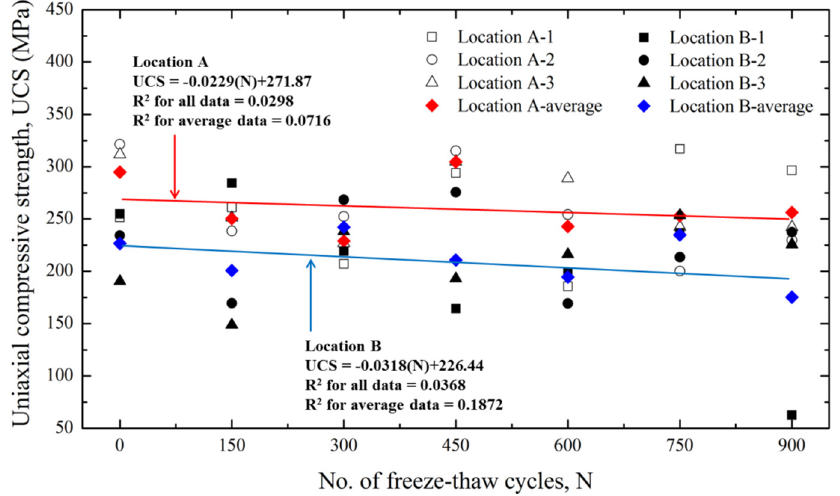
Figure 8. Uniaxial compressive strength changes with increasing freezing-thaw cycle of Locations A and B.